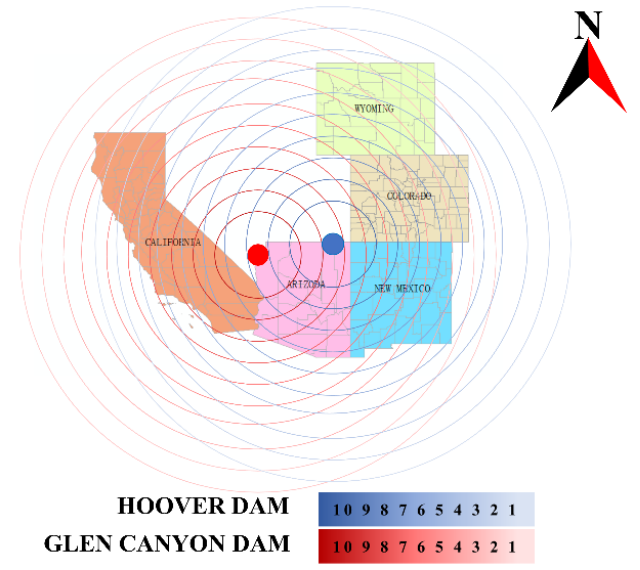
Figure 6. Distance quantization ideal schematic. Population, Gross Agricultural Product, Gross Industrial Product, population, and distance distribution values to GCD and HD were statistically compiled for the 193 counties in the four states in 2020. Table 2 shows the results for the selected areas. Table 2. Assignment of four major attributes to selected counties in five states. Only the first three and the last two are excerpted here.